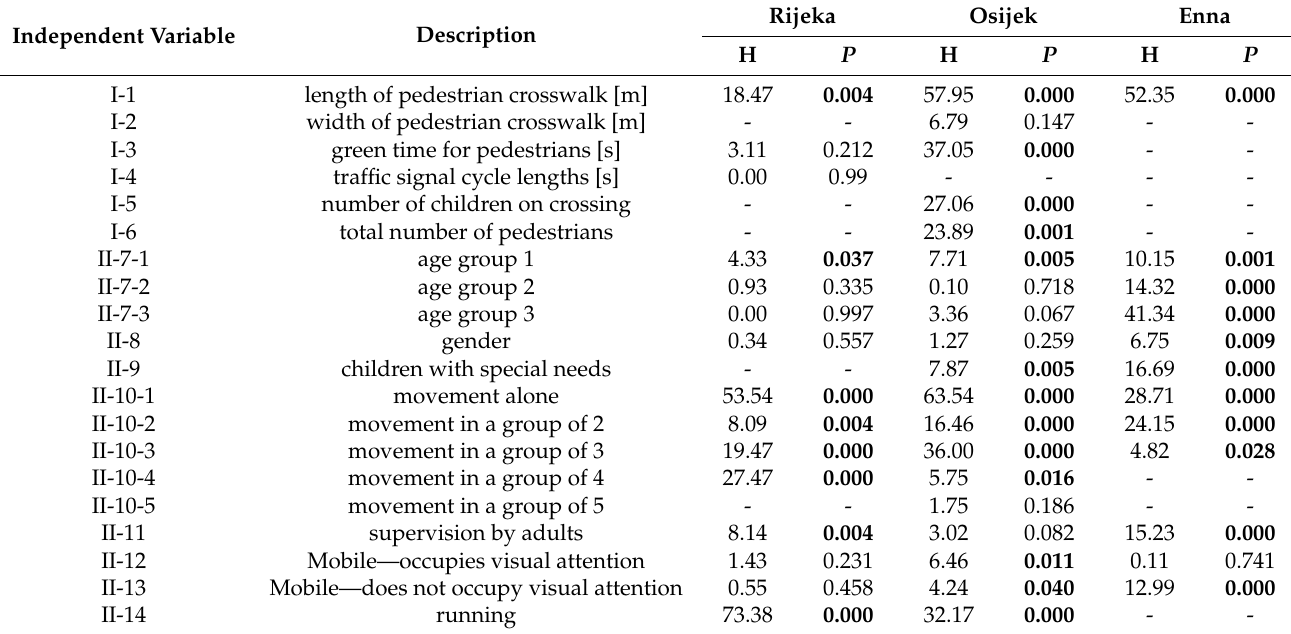
Table 11. Influence of specific independent variable on dependent variables based on the Kruskal-Wallis test. Independent